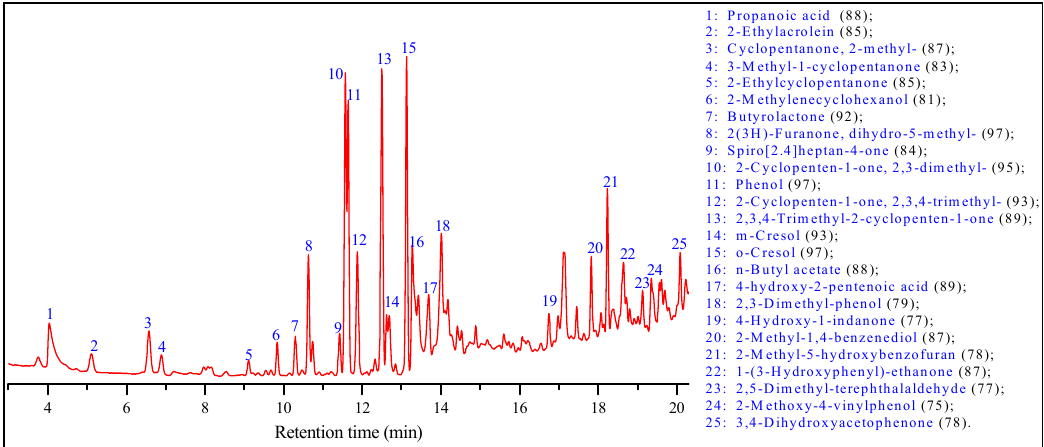
Figure 4. GCMS analysis of the methylene chloride extracted products in ADH solution. Values in parentheses indicate similarities (%) identified the NIST08 mass spectral data library. Table 1. Properties of HPFA and ADH solution.